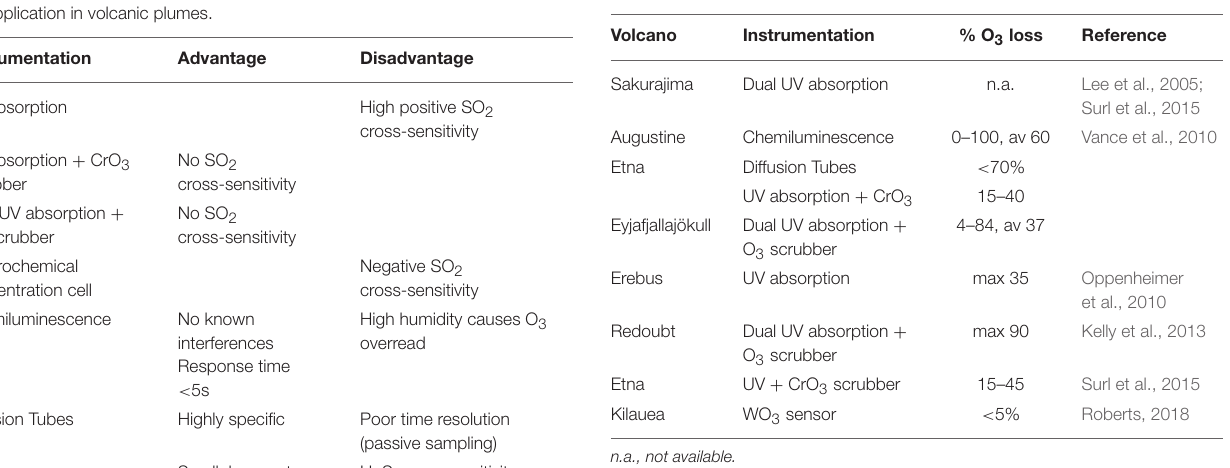
TABLE 3 | Overview of sampling campaigns on O 3 depletion in volcanic